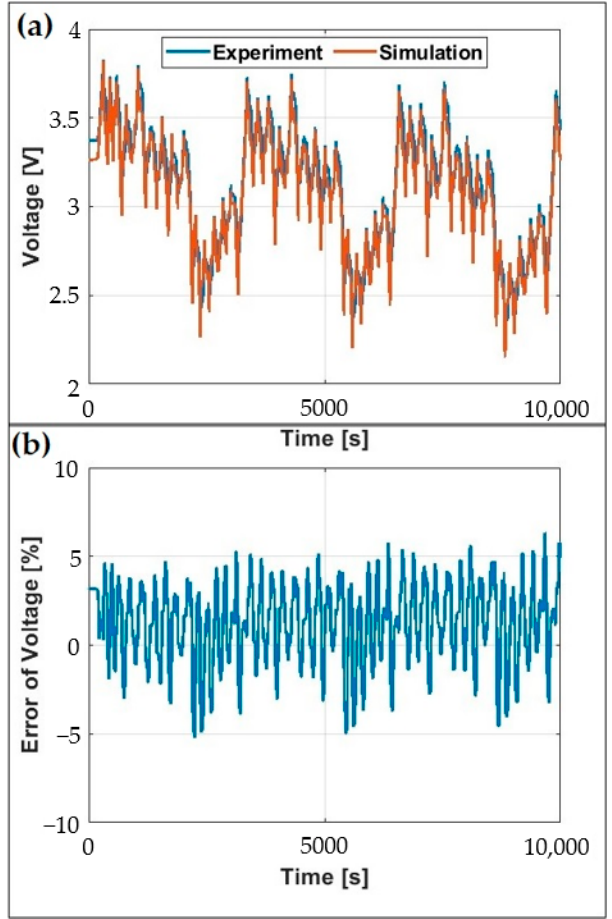
Figure 8. Validation of the second-order ECM: ( a ) verification of the simulation and experimental results of voltage, ( b ) error of validation.